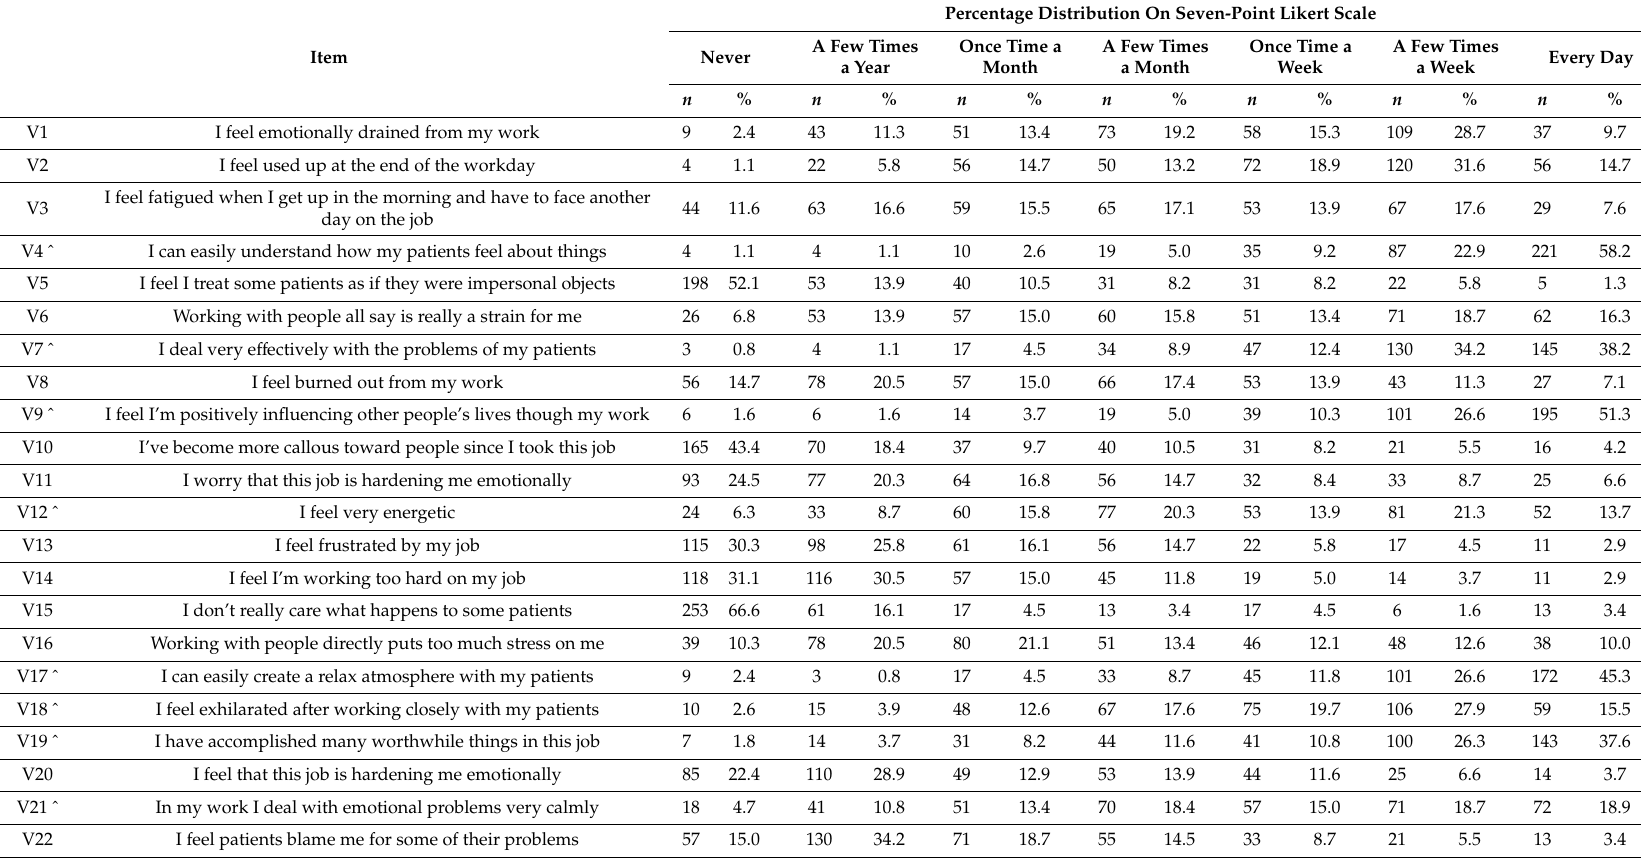
Table 2. Distribution of burnout levels among dentists of Lithuania under the Maslach burnout inventory ( N =